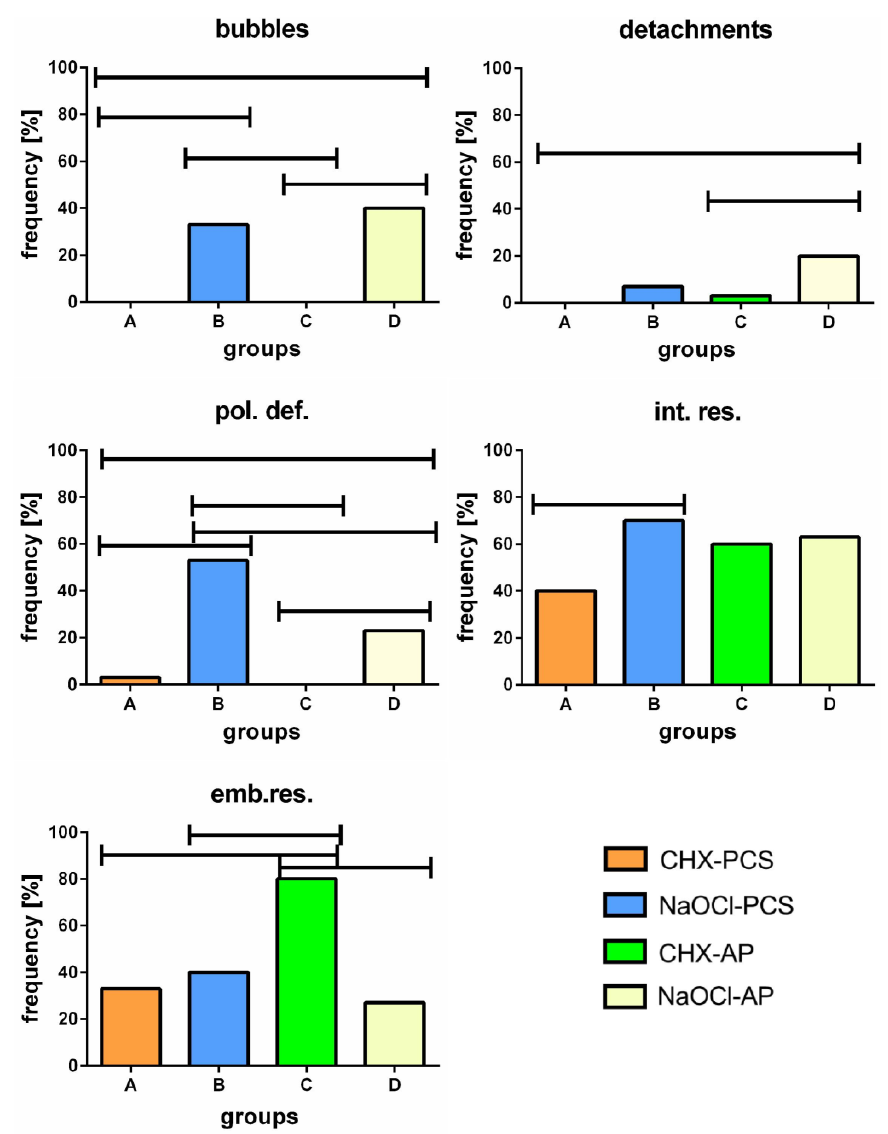
Figure 5. Frequency of the different defects found in each group. (pol.def = polymerization defects; int.res = endodontic cement residues at the dual cement-dentin interface; emb.res = embedded residues of endodontic cement into the dual cement